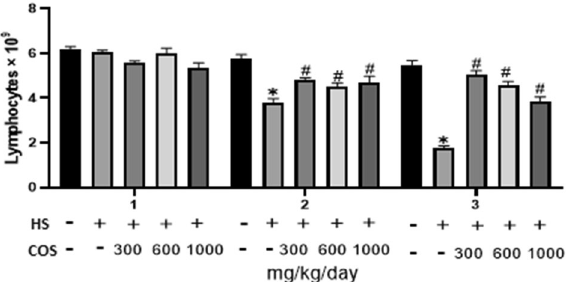
Figure 5. Effect of chitosan treatment on lymphocytes. Control: normal mice; HS: Heat stress mice; COS-LD: mice treated with HS plus COS (300 mg/kg); COS-MD: mice treated with HS plus COS (600 mg/kg); COS-HD: mice treated with HS plus COS (1000 mg/kg). Data are expressed as mean ± standard error. *Indicates p < 0.05 compared with the blank control group, # Indicates p < 0.05 compared with the HS control group.